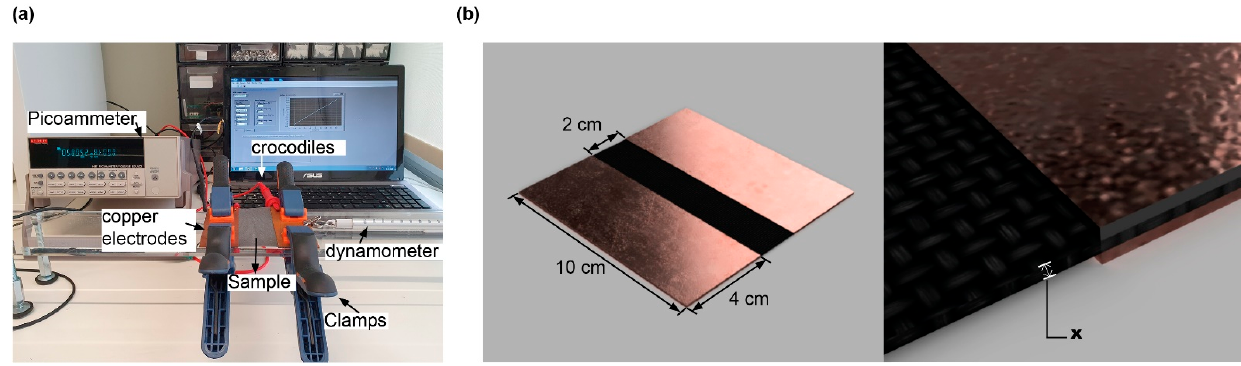
Figure 3. ( a ) Electrical Resistance test set-up (I–V curves); ( b ) sample placement demonstration be- tween four copper electrodes, where x represents the sample thickness.